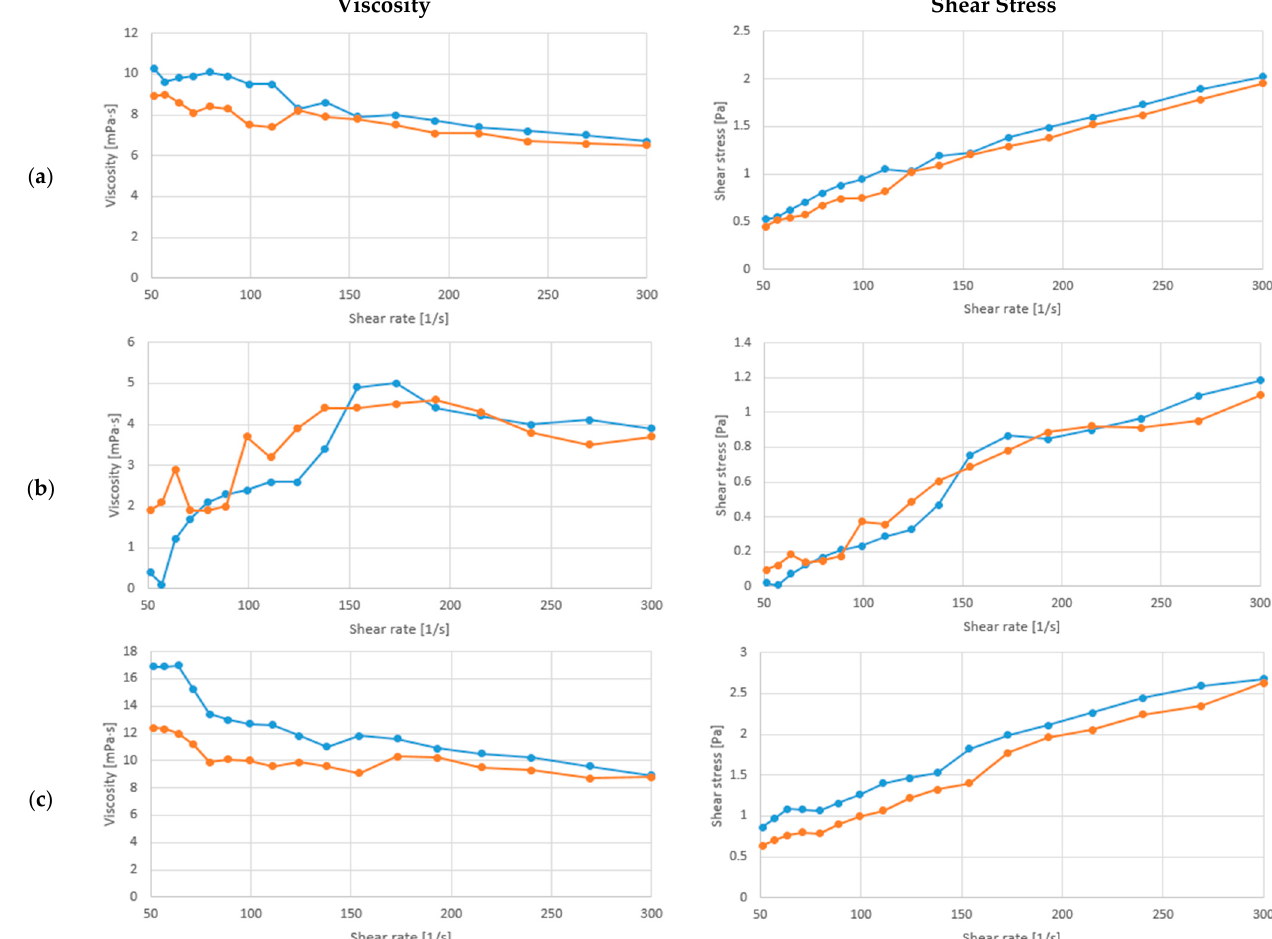
Figure 4. Relationship between viscosity/shear stress and increasing shear rate at 20 °C of the sample with ( a ) Soy drink + L. rhamnosus, ( b ) Soy drink + L. rhamnosus + Xylitol , ( c ) Soy drink + L. rhamnosus with ( a ) Soy drink + L. rhamnosus, ( b ) Soy drink + L. rhamnosus + Xylitol, ( c ) Soy drink + L. rhamnosus + C. vulgaris + Xylitol (experiments effectuated in duplicate red and blue line). + C. vulgaris + Xylitol (experiments effectuated in duplicate red and blue